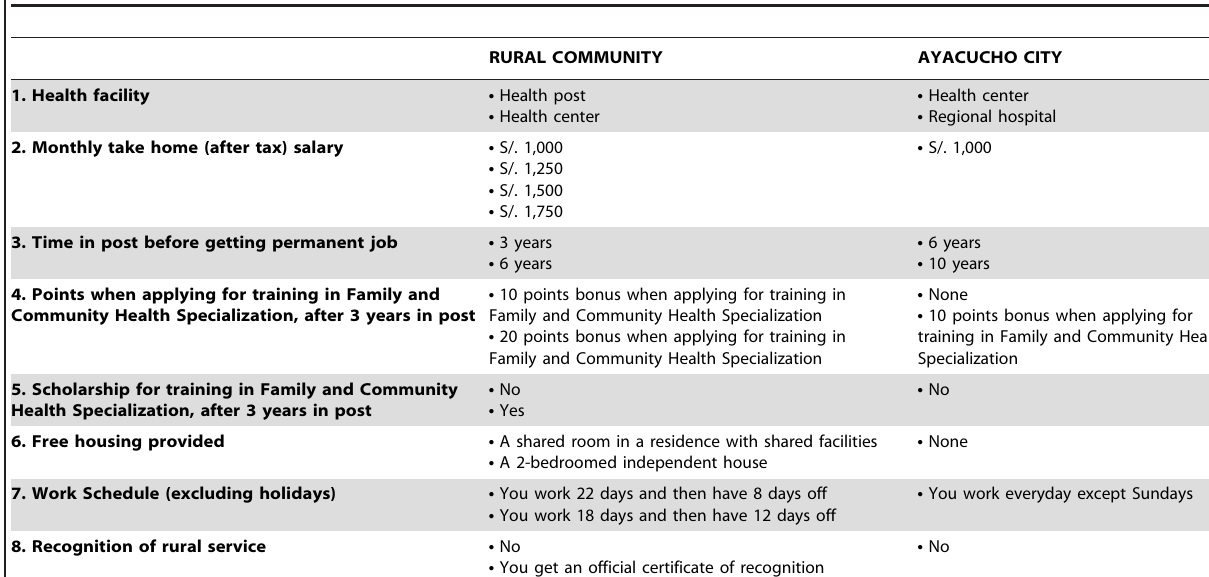
Table 2. Final DCE design.